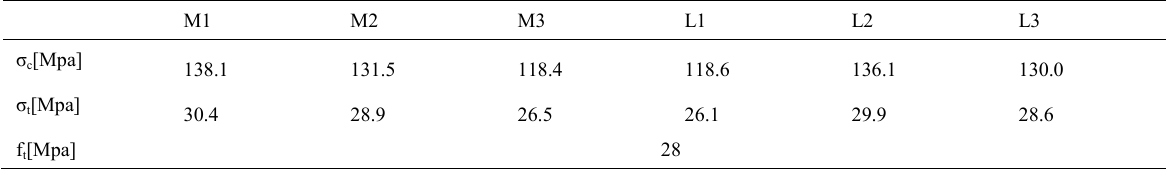
Table 4: Compressive stress σ c and calculated tensile stress σ t .